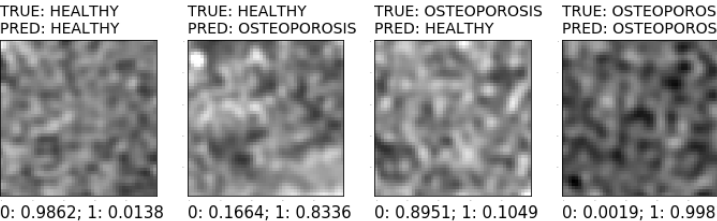
Figure 16. Various prediction results of sample images.